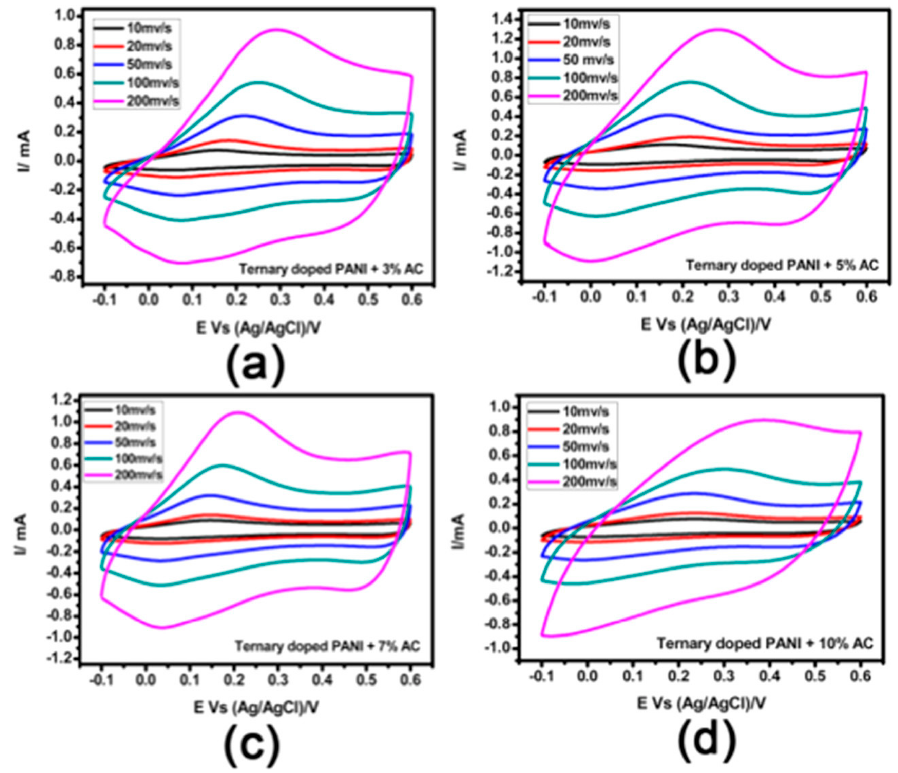
Figure 9. Electrochemical cyclic voltammetry (CV) curves of ternary doped PANI-AC composites at different scan rates and AC percentages ( a ) 3%; ( b ) 5%; ( c ) 7%; ( d ) 10%. Reprinted with permission from [102]. Copyright (2020) American Chemical Society.